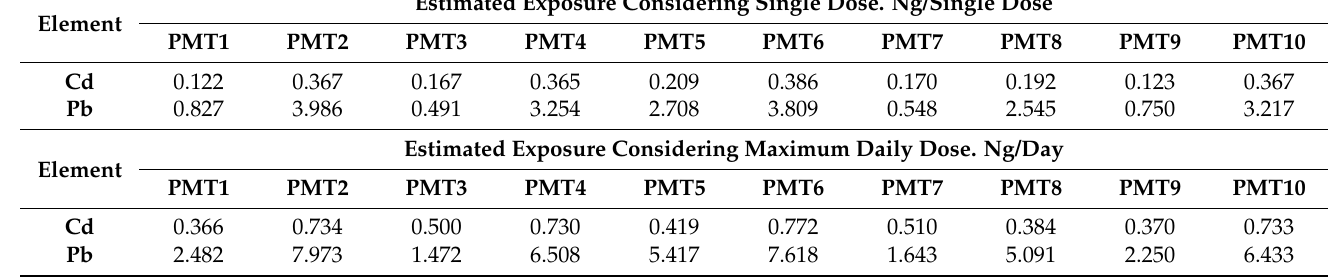
Table 4. The estimated values of exposure of Cd and Pb considering single-dose and maximal